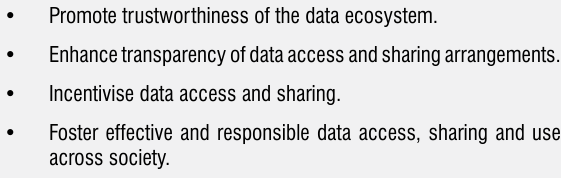
Table 1 categorises the rigour of national data protection laws regarding cross-border transfer of personal data. 38 Table 1 is not aimed at